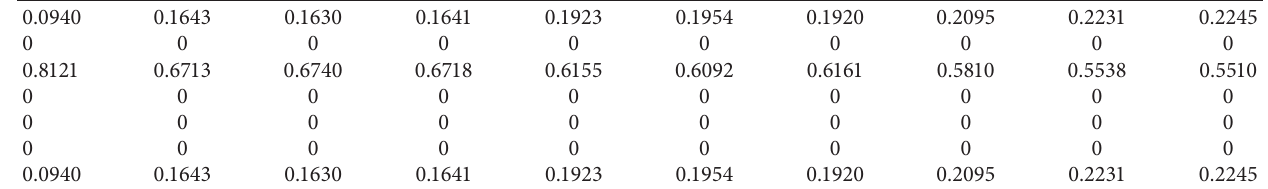
Table 3: The membership results of the SNCM algorithm on the aggregation data set.